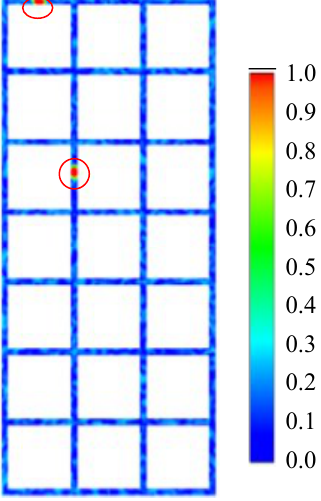
Figure 12. The result of corrosion diagnosis on the simulated grounding grid.